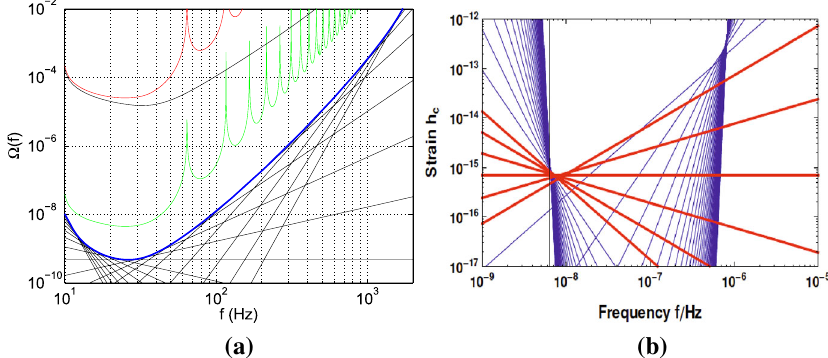
Fig. 82 Panel a shows the sensitivity of the advanced LIGO Hanford–Livingston detector pair in terms of gravitational-wave energy density Ω gw ( f ) using a variety of methods. The blue line is the sensitivity to isotropic stochastic signals with power-law spectra, formed from the envelope of backgrounds with a wide range of spectral slopes (shown as straight black lines ). Also shown as a black curve is the noise spectral density of a single LIGO detector converted to units of Ω ( f ) . The red and green lines are variants of h eff ( f ) , again converted to units of Ω ( f ) . The lower green curve is for an observation time of 1year and Δ f = 0 . 25Hz. Panel b shows the characteristic strain sensitivity for a hypothetical pulsar timing array formed from the envelope of a large number of power law models. The red lines show a subset of the power law models used. The upper and lower frequency limits to the sensitivity are set by the observation cadence andtheobservationtime,respectively.ImagesreproducedwithpermissionfromThraneandRomano(2013), copyright by APS (Panel a ); and from Moore et al. (2015b), copyright by IOP (Panel b